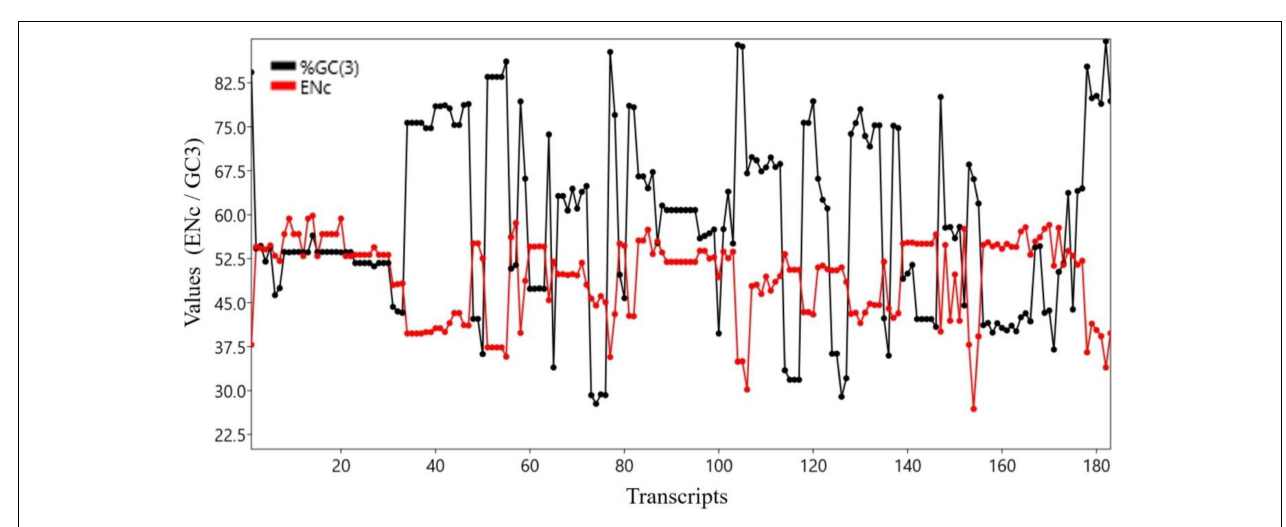
FIGURE 2 | Distribution of GC content at various codon positions.